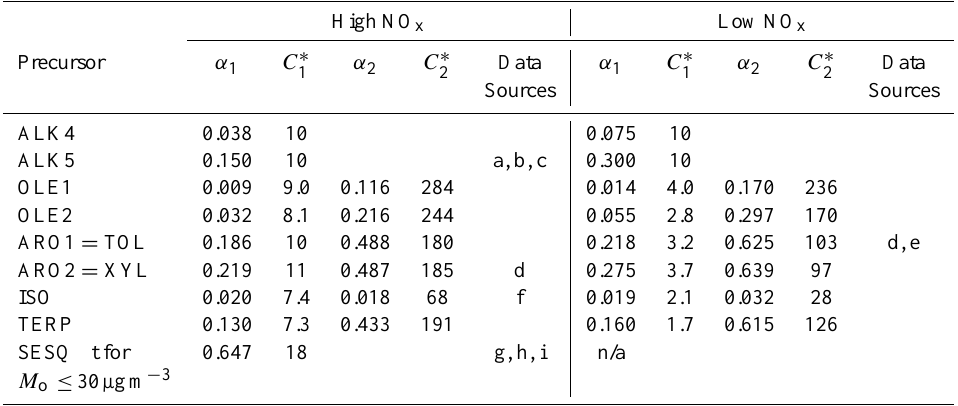
Table 1. 2p-VBS parameters, based on VBS parameters of Tsimpidi et al. (2010), for SOA precursors under high- and low-NO x conditions at T = 298K and ρ = 1.5gcm − 3 .